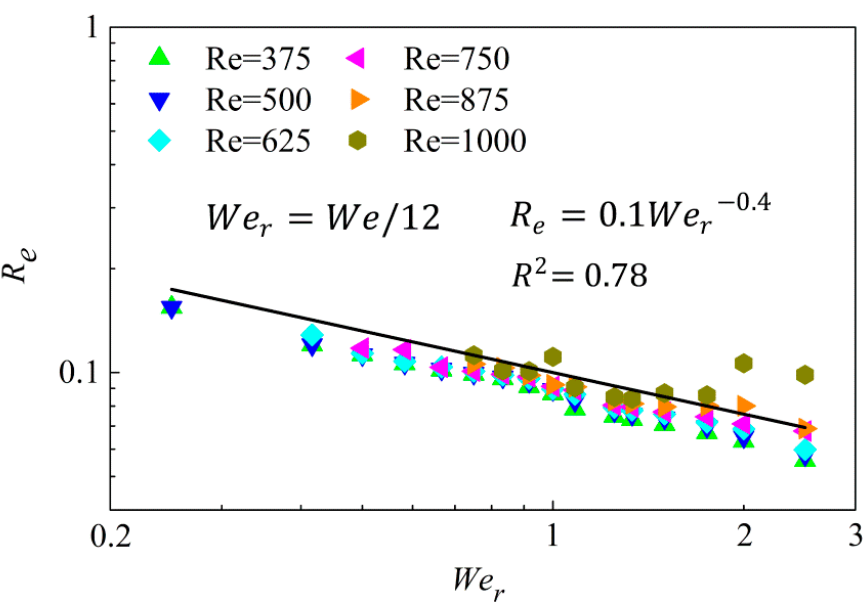
⁄ and re- = ℎ 𝐷 (cid:3032) (cid:3032) (cid:3040)(cid:3028)(cid:3051)